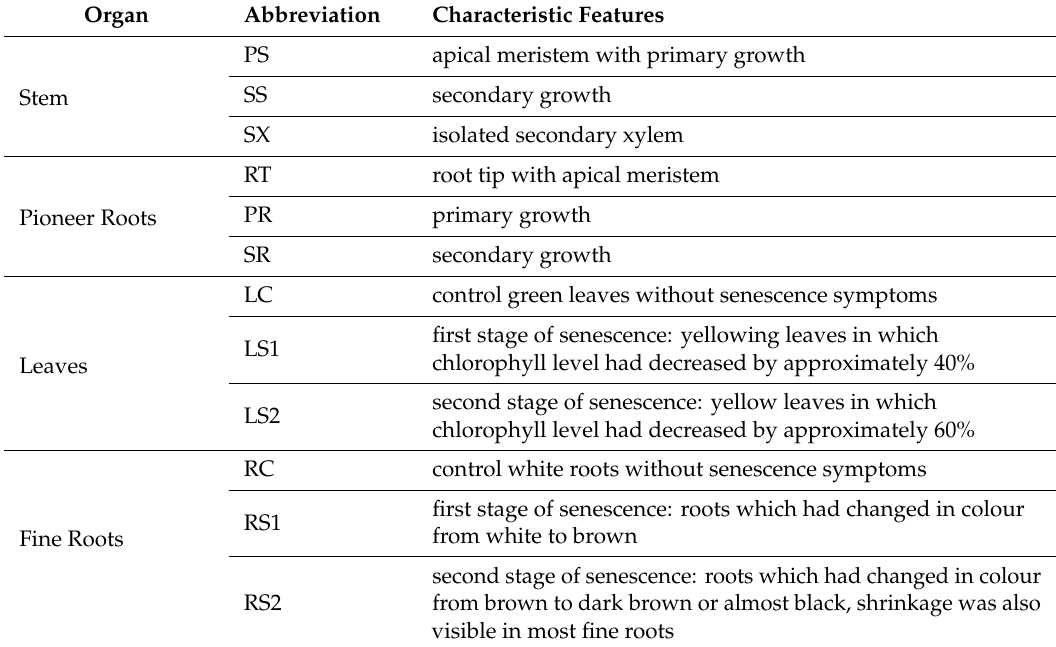
Table 1. Nomenclature describing the sampling of Populus trichocarpa stems, pioneer roots, leaves and fine